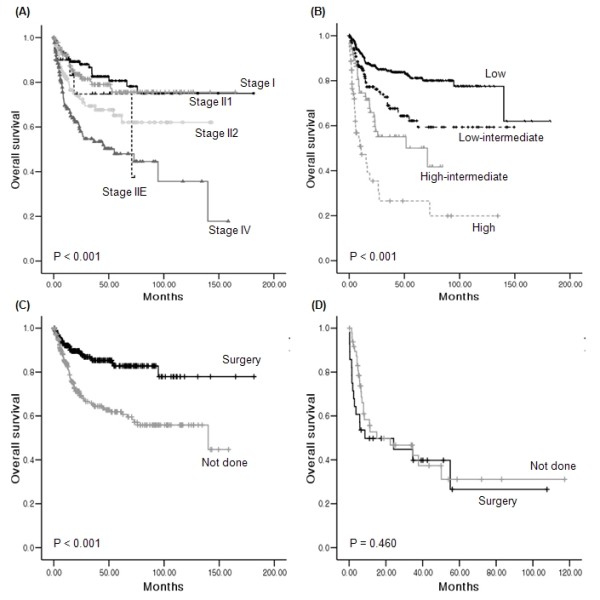
Comparison of survival curves based on the clinical characteristics. (A) Lugano stage II2 and IV cases had significantly worse OS, while there were no significant differences in OS between stage I and II1. (B) IPI was significantly associated with OS. (C) In B-cell lymphoma, patients who underwent surgical resectioning had better OS than patients that did not. (D) Surgical resections failed to lead to survival differences in T-cell lymphoma.